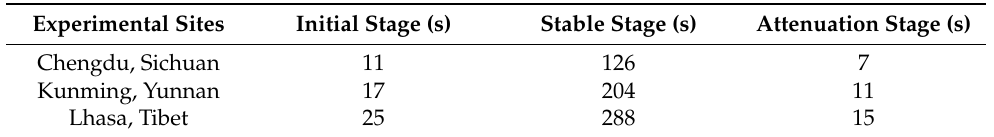
Table 4. Time durations of different stages in the three experimental sites.